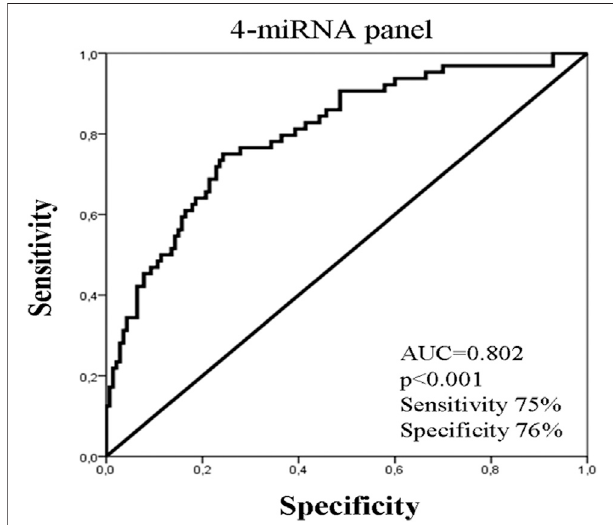
FIGURE 2 | ROC curve analysis depicting the performance of a 4- miRNA panel consisted of miR-19a, miR-20a, miR-126, and miR-155 to distinguish early from metastatic breast cancer patients. AUC, area under